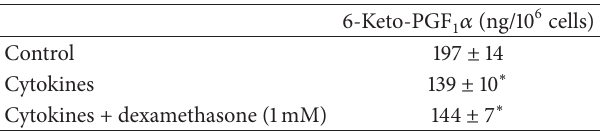
Table 2: Conversion of the precursor endoperoxide PGH 2 to 6- Keto-PGF 1 𝛼 in the presence of cytokines or